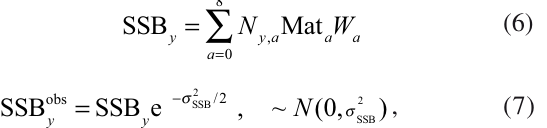
Fig . 2. – Selectivity and N-at-age ratio used to parameterize the operating model in simulating the dynamics of bigeye tuna stock (S_LL, selectivity of longline; S_PS, selectivity of purse seine; N- age,